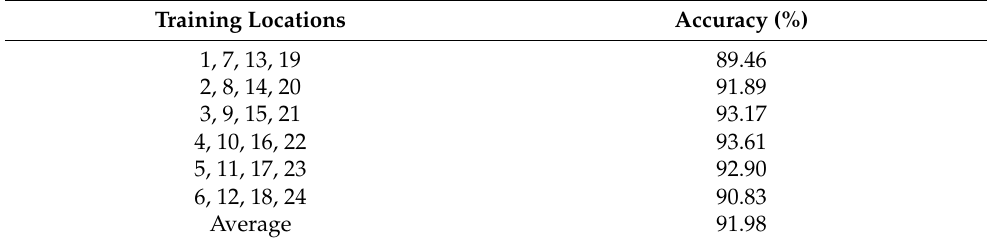
Table 7. The average recognition accuracy for distinct four-training-position combination scheme.